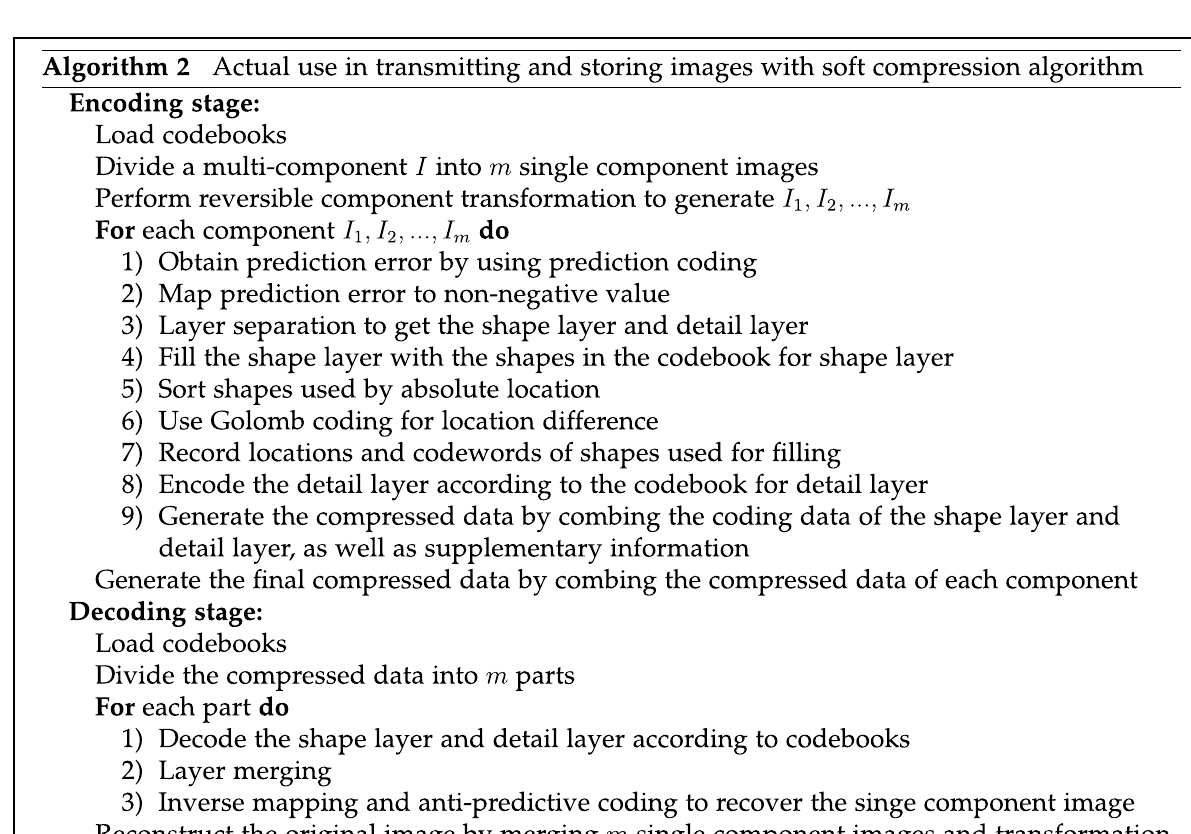
Figure 7. Encoding and decoding stage with soft compression algorithm for multi-component image. They will be applied after codebooks are